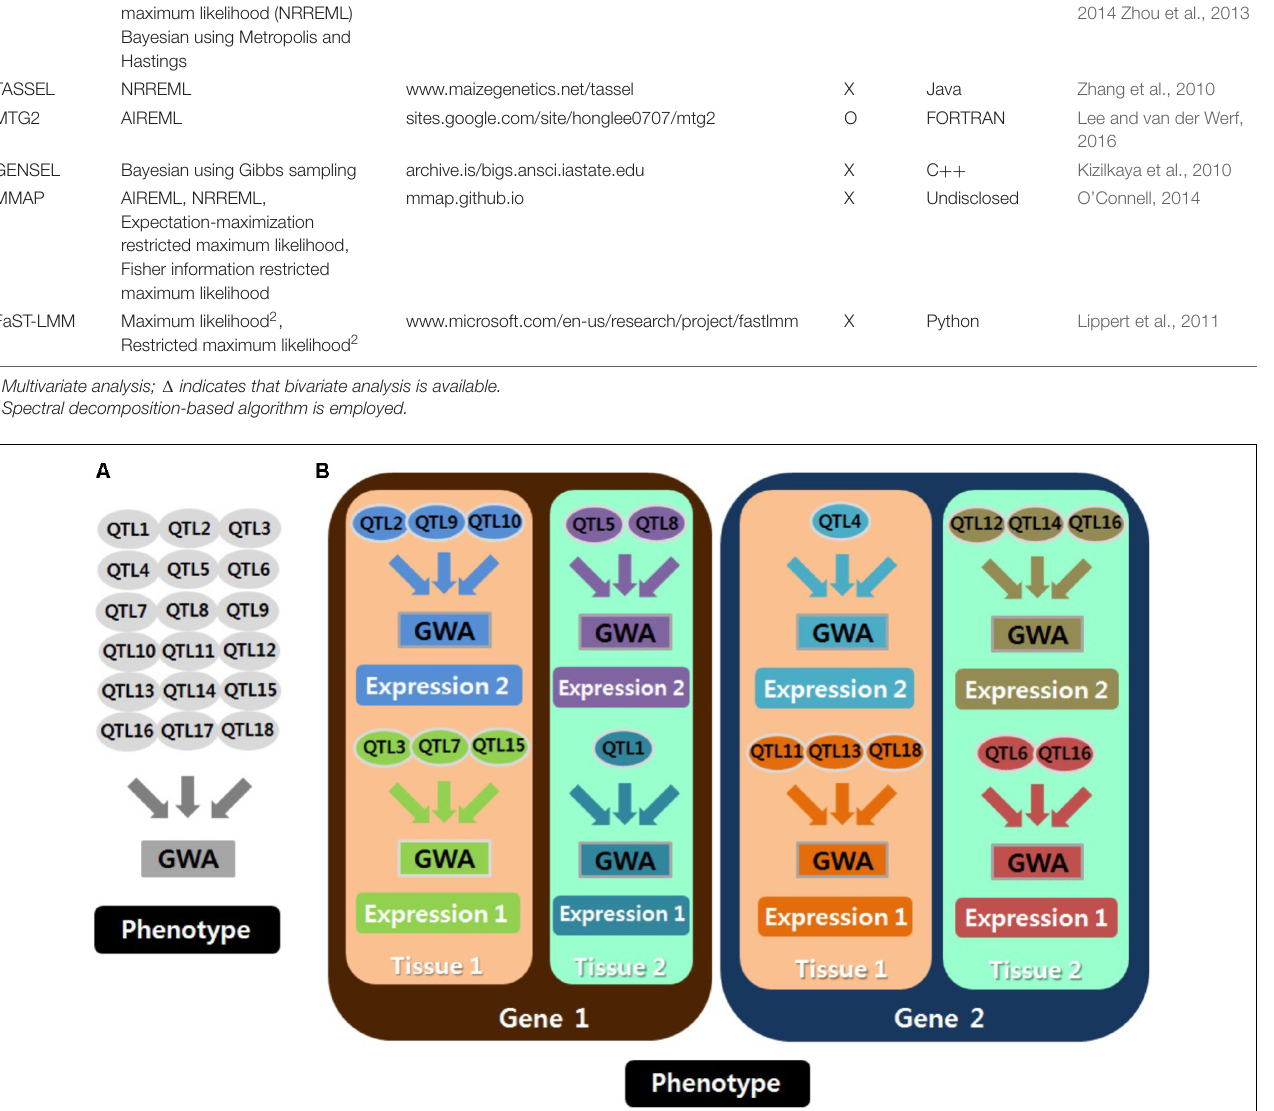
and the Metropolis and Hastings algorithm (Gilks et